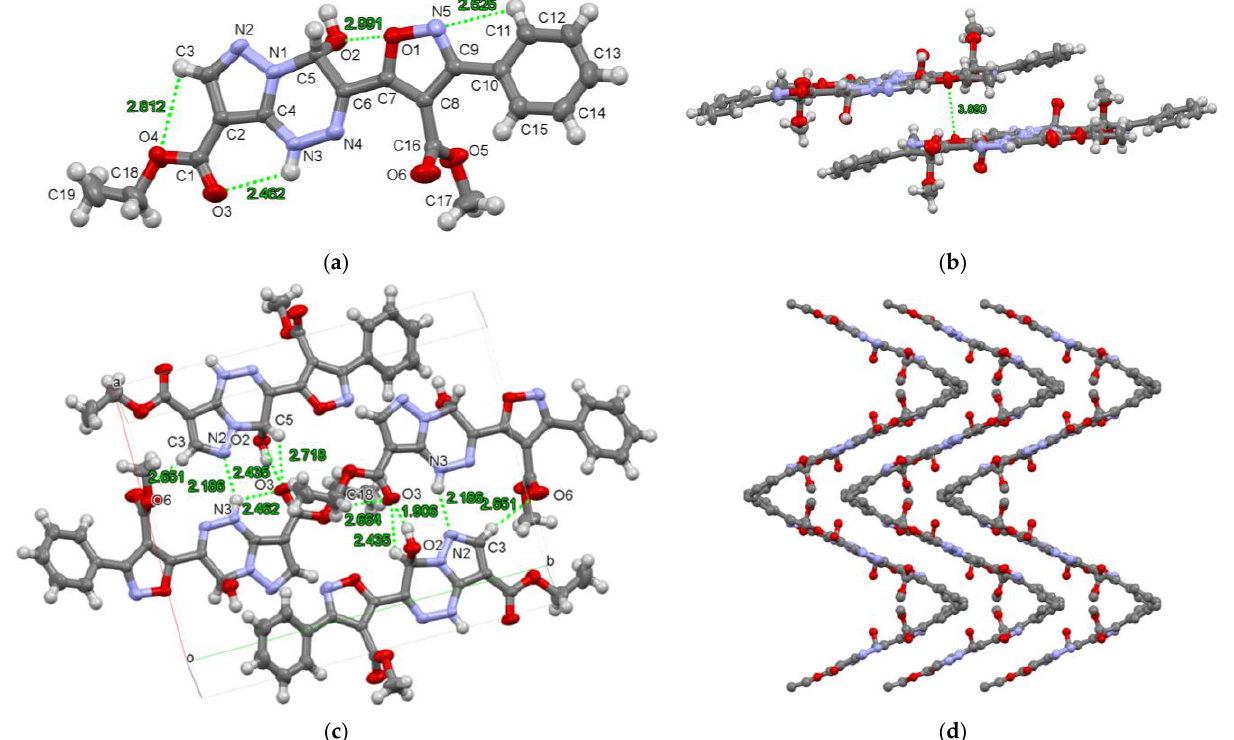
Figure 2. The molecular structure of DAT–OH 13b according to X-ray diffraction data level: ( a ) front view with intramolecular bonds; ( b ) arrangement of molecules in two parallel sheets; ( c ) layer of neighboring molecules with intermolecular noncovalent bonds (R VdW (O–H) = 2.5 Å, R VdW (N–H) = 2.6 Å, R VdW (N–O) = 3.35 Å, R VdW (N–O) = 3.25 Å); ( d ) partial packing diagram along the crystallographic axes a ( d ). Hydrogen atoms omitted for clarity.